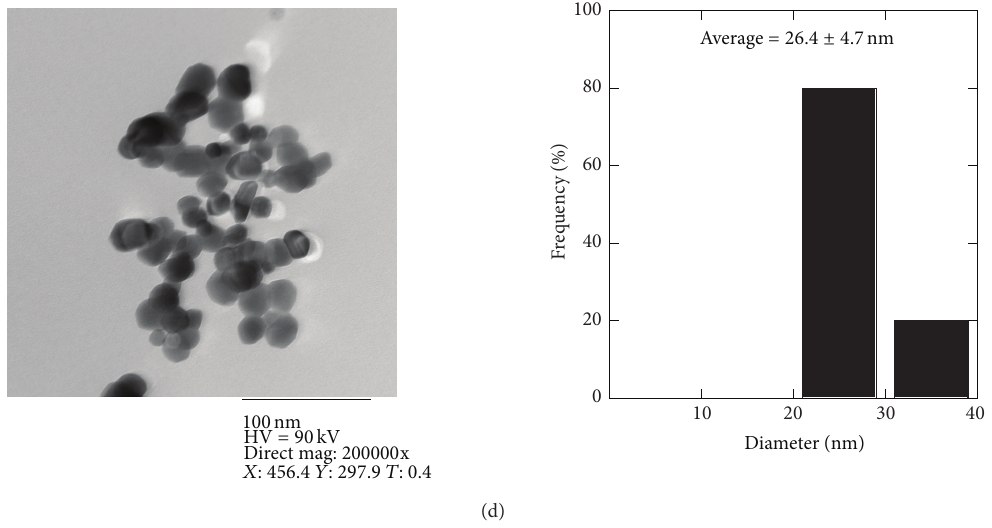
Figure 4: TEM images of iron oxide